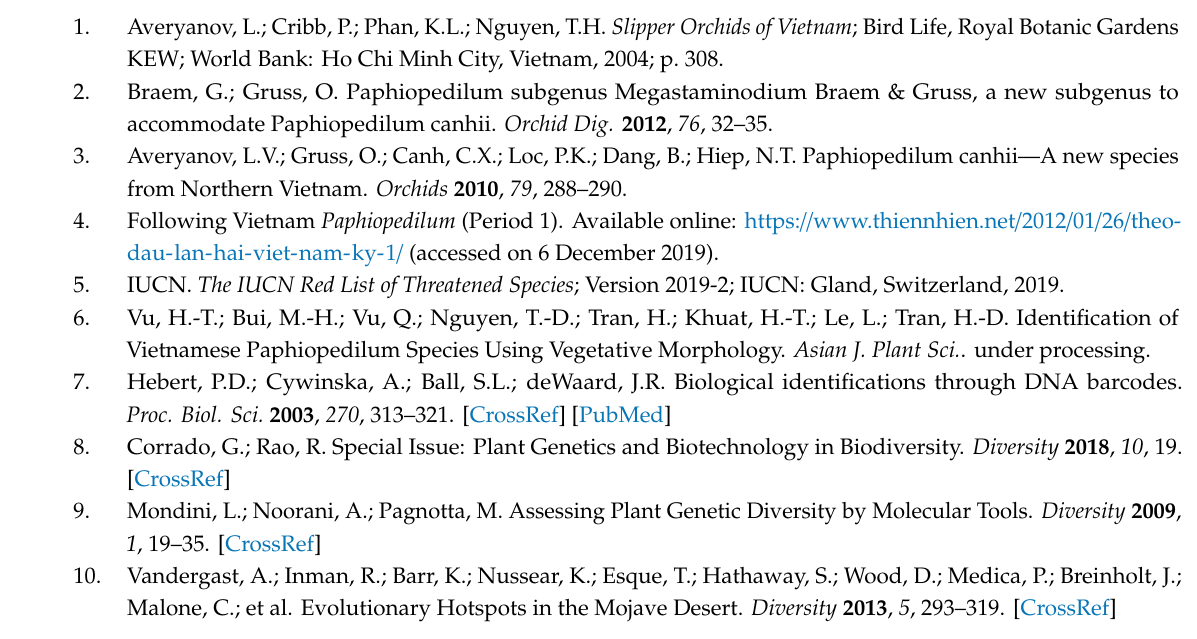
Figure S1. Phylogenetic trees of 8 endemic Paphiopedilum species based on single and 2-locus combined sequences of ITS, mat K, trn L, rpo B, rpo C1. Figure S2. Estimates of evolutionary divergence between sequences of 8 endemic Paphiopedilum species based on 5 single sequences ITS, mat K, trn L, rpo B, rpo C1. Figure S3. Phylogenetic trees of 21 Vietnamese Paphiopedilum species based on ITS region using di ff erent methods. Figure S4. Phylogenetic trees of 21 Vietnamese Paphiopedilum species based on mat K region using di ff erent methods. Figure S5. Phylogenetic tree of 21 Vietnamese Paphiopedilum species based on trn L region using di ff erent methods. Table S1. Full scientific name, vernacular name, distribution areas, IUCN Red List state and endemic list of Vietnamse Paphiopedilum species.Table S2. Specimen voucher, collected source and accession numbers of studied Paphiopedilum samples.Table S3. Primers for screening of ACO and LEAFY in the study.Table S4. Species resolution results on 8 Paphiopedilum endemic species (dataset